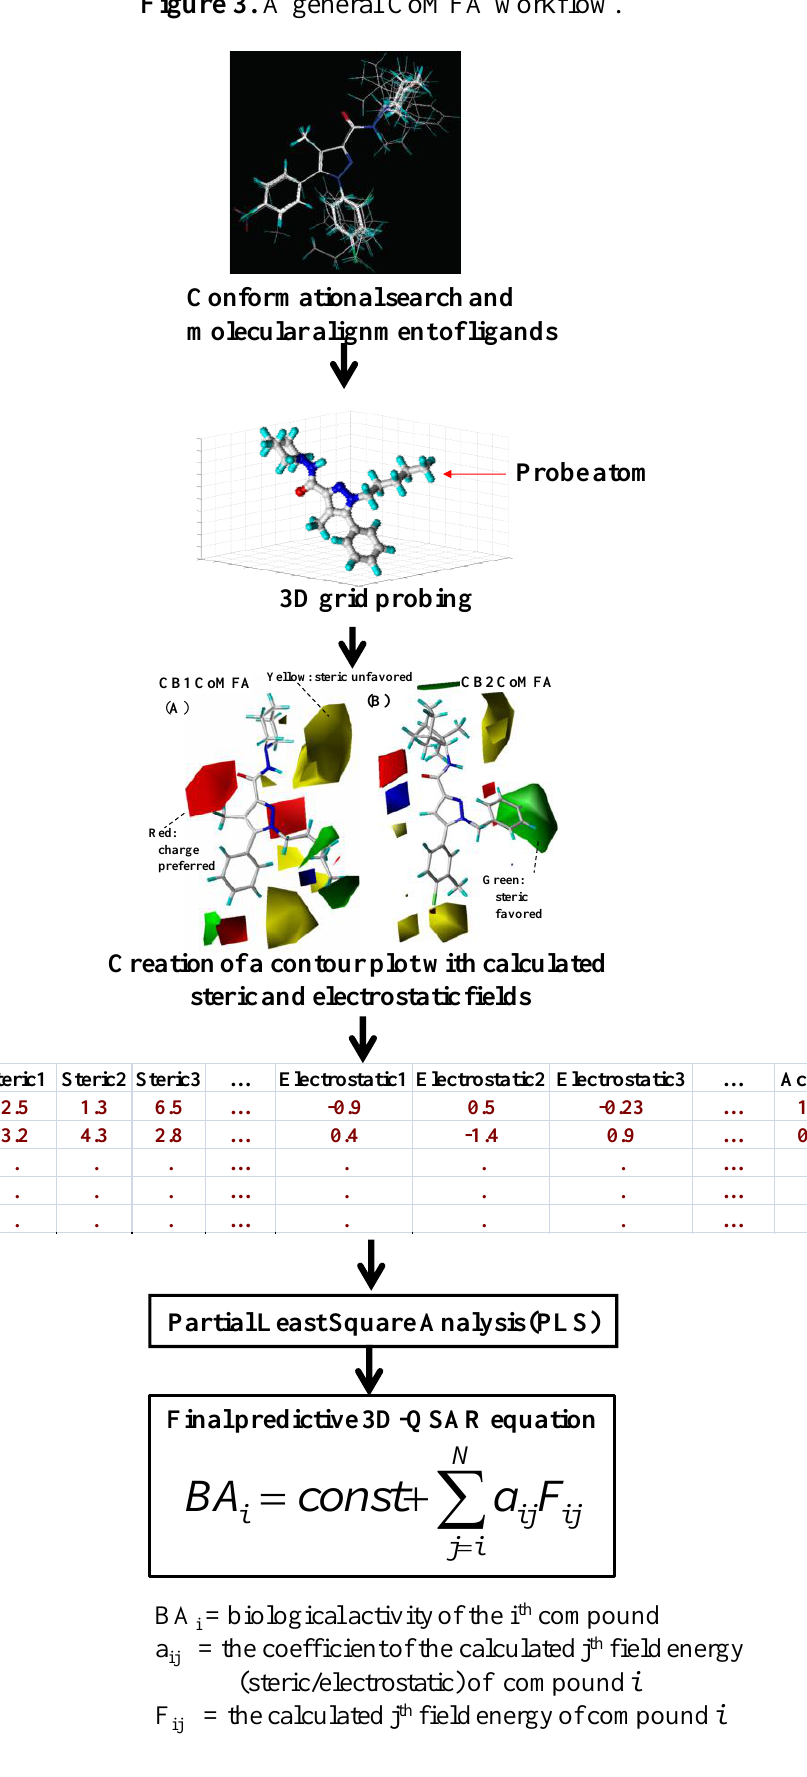
Figure 3. A general CoMFA workflow.